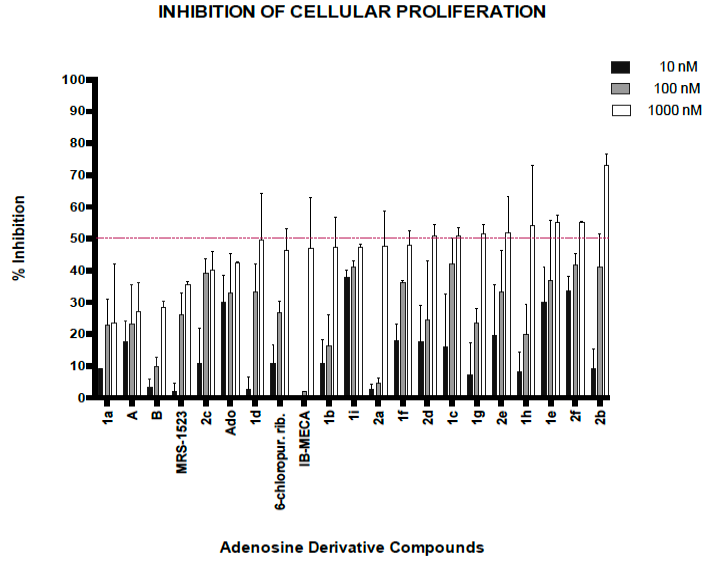
Figure 6. The ability of adenosine derivatives to inhibit the proliferation AGS cells (gastric Figure adenocarcinoma) was assessed. Three concentrations (10 nM, 100 nM and 1000 nM) for each compound were tested. Compounds of the series 1 ( 1a – 1h ), 2 ( 2a – 2f ), the selective agonist (IB-MECA) and antagonist (MRS-1523), the protected adenosine (A) modified 5 ′ -OH group and